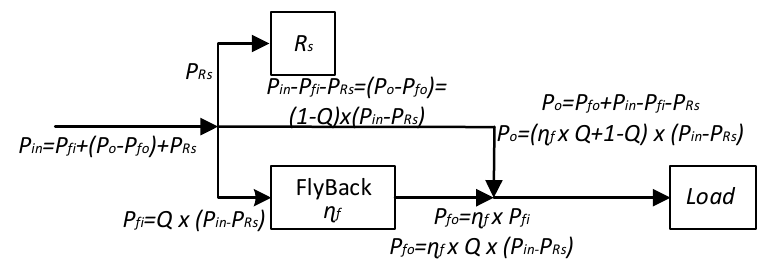
Figure 9. Power flowchart.